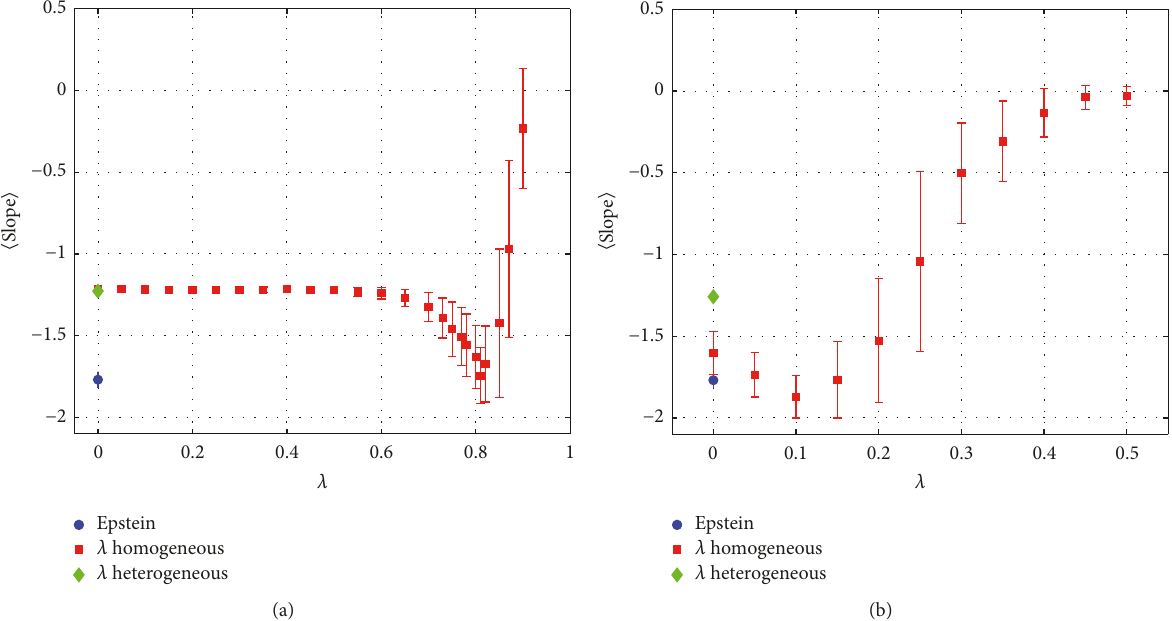
Figure 11: (a) shows the slope associated with the cascade of the power spectrum as a function of the saving parameter with 𝐿 = 0.82 and in (b) the results corresponding to the simulations with 𝐿 = 0.89 are shown. With red squares, the slope is drawn for the model with homogeneous saving, and the blue circle corresponds to the value obtained with the Epstein model, while the green diamond is the result for the slope in the model with heterogeneous